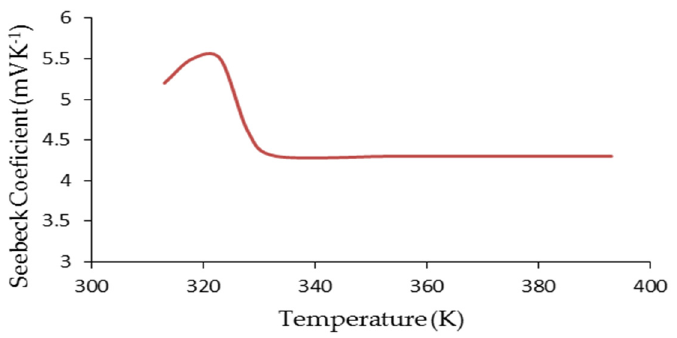
Figure 2. Seebeck coefficient of graphite/mixture/aluminum system as a function of temperature.